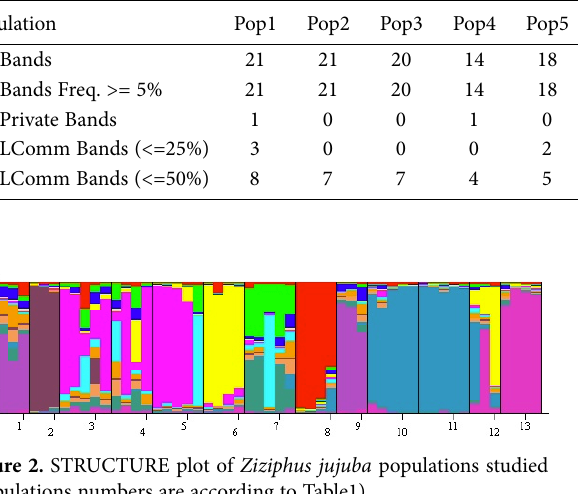
Table 8. Genetic distance among jujube cultivars based on cp-DNA PSBA sequences (populations numbers are according to Table